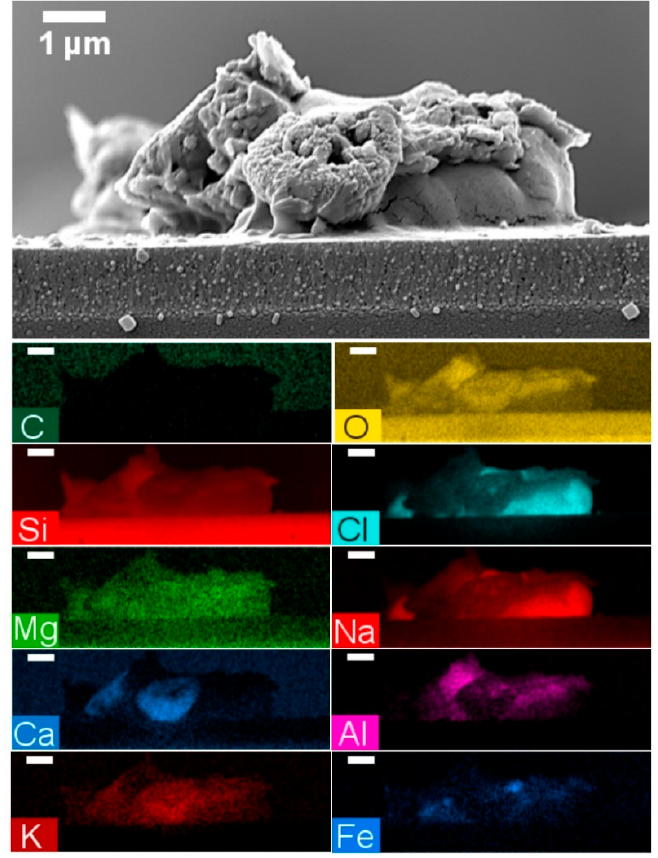
Figure 13. SEM and energy-dispersive X-ray spectroscopy (EDX) (coloured elemental images) of cementation on an uncleaned B coupon at week 8. Elements detected are C, O, Si, Cl, Mg, Na, Ca, Al, K, and Fe. The white scale bar represents 1 µm in each image. Table 2. EDX analysis showing the elemental composition of soiling corresponding to the images shown in Figures 13 and 14. Figure Description